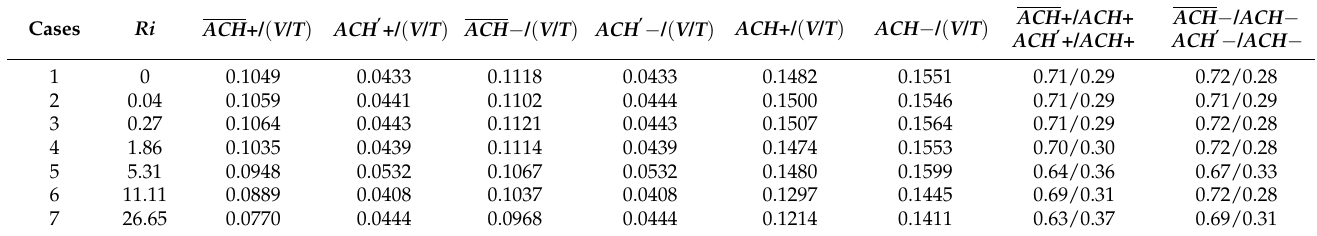
Table 3. Dimensionless air exchange rate ( ACH +/ − ) for cross-ventilation under different Ri cases.